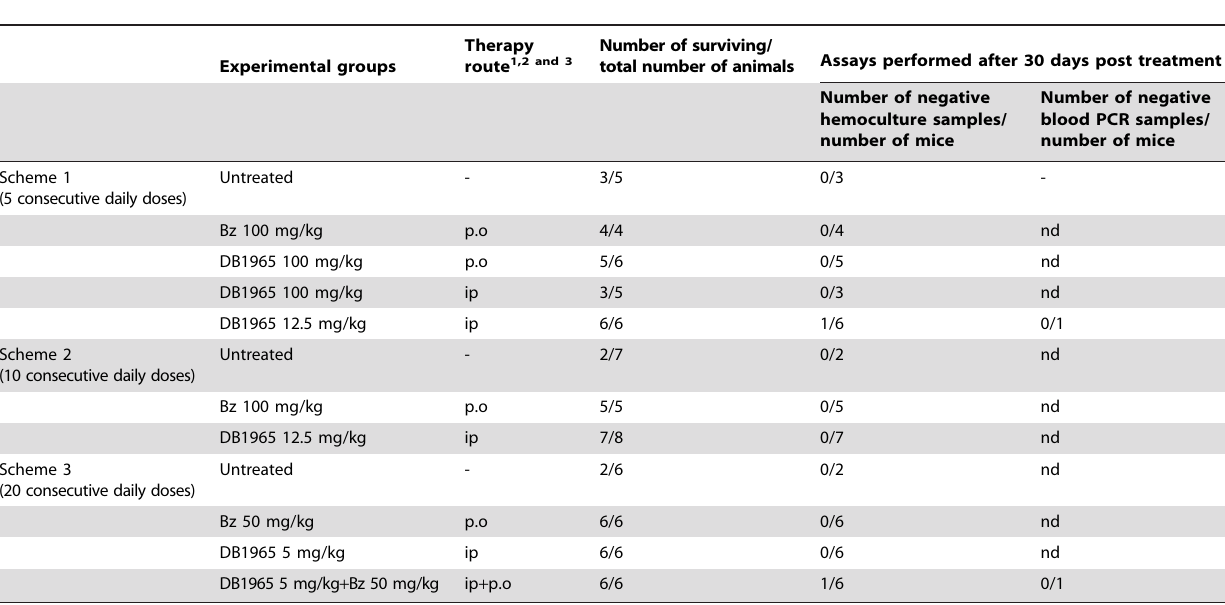
Table 4. Cure assessment of DB1965 combined or not with benznidazole (Bz) in murine model of acute T. cruzi -infection 1